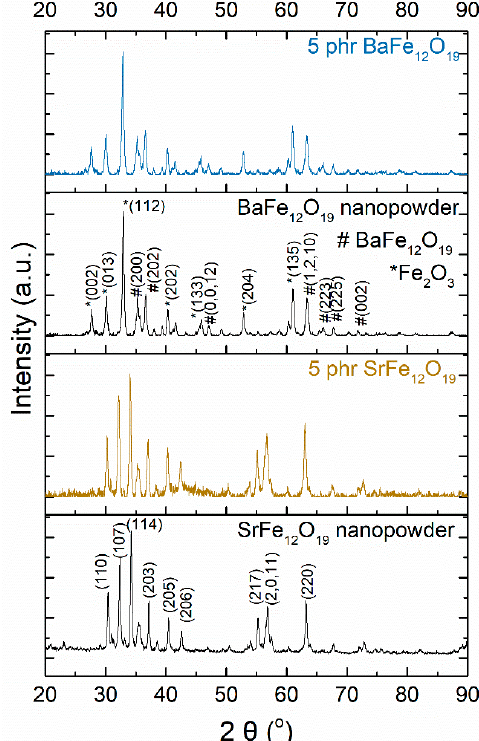
Figure 2. X-ray diffraction (XRD) spectra of the BaFe 12 O 19 and SrFe 12 O 19 nanopowders and their respective nanocomposites with 5 phr filler content.